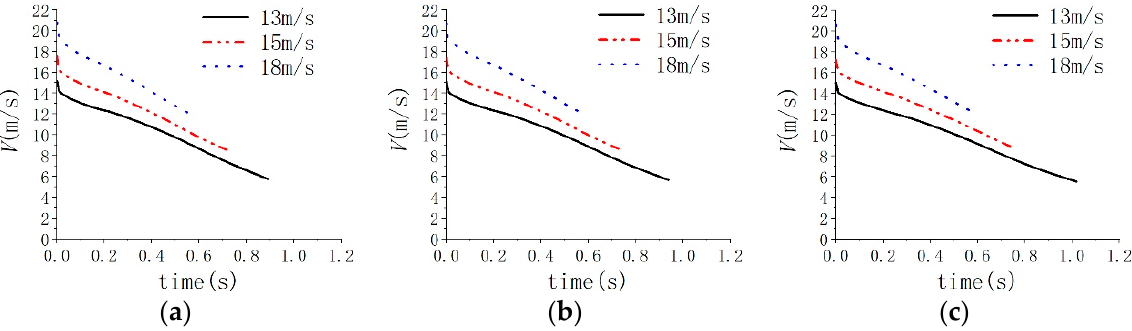
Figure 18. Images of axial velocity variation of vehicles under different initial velocities. ( a ) Axial velocity of vehicle in case 1, 4, 7. ( b ) Axial velocity of vehicle in case 2, 5, 8. ( c ) Axial velocity of vehicle in case 3, 6, 9.